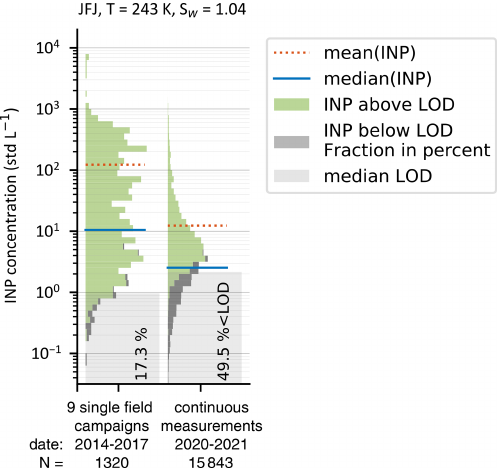
Figure A2. Total INP frequency distributions from nine single field campaigns between 2014 and 2017 by Boose et al. (2016) and Lacher et al. (2018) and continuous measurements from the current work between February 2020 and January 2021, both sampled at JFJ including SDE and BG